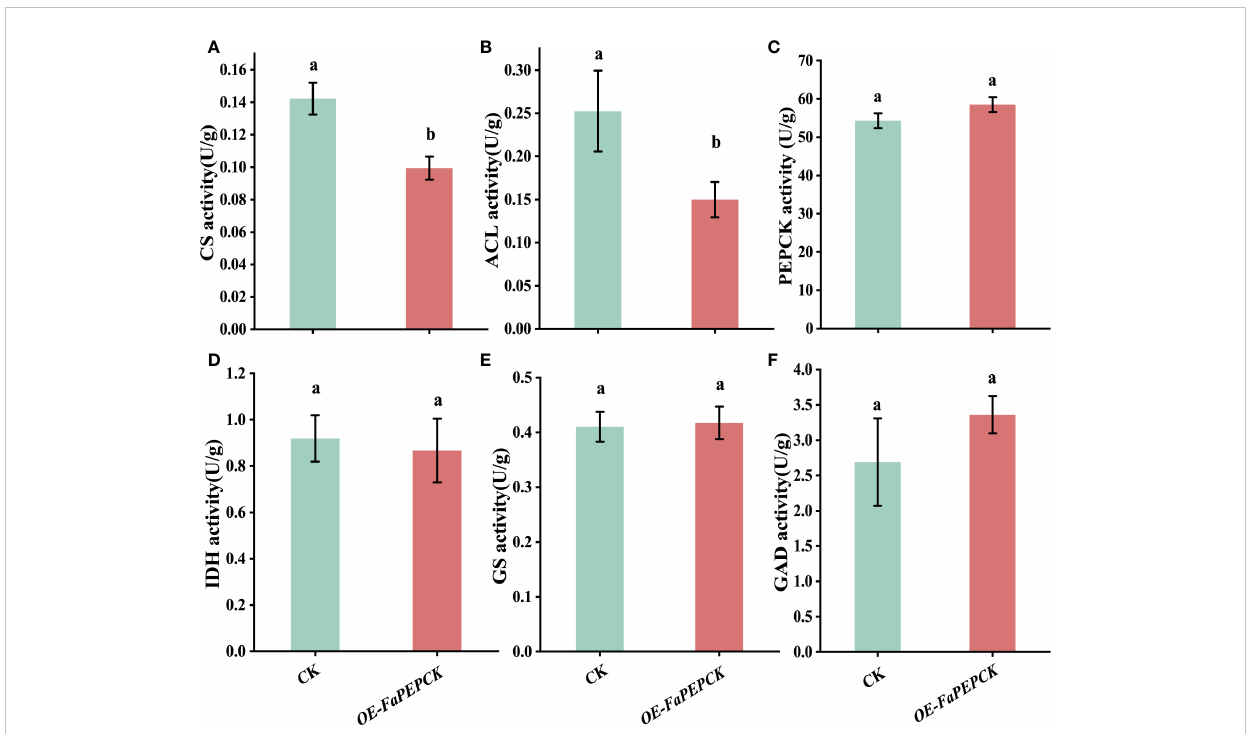
FIGURE 7 Enzymatic activity involved in the citric acid metabolism in FaPEPCK- overexpressed fruits. CS activity (A) , ACL activity (B) , PEPCK activity (C) , IDH activity (D) , GS activity (E) , GAD activity (F) . CS, Citrate synthase; ACL, ATP-citrate lyase; PEPCK, phosphoenolpyruvate carboxykinase; IDH, isocitrate